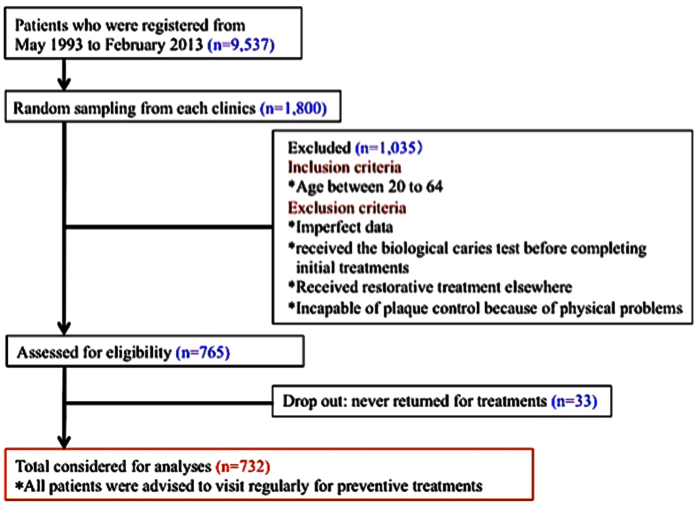
The selection process for patients undergoing survival and survival CART analysis.